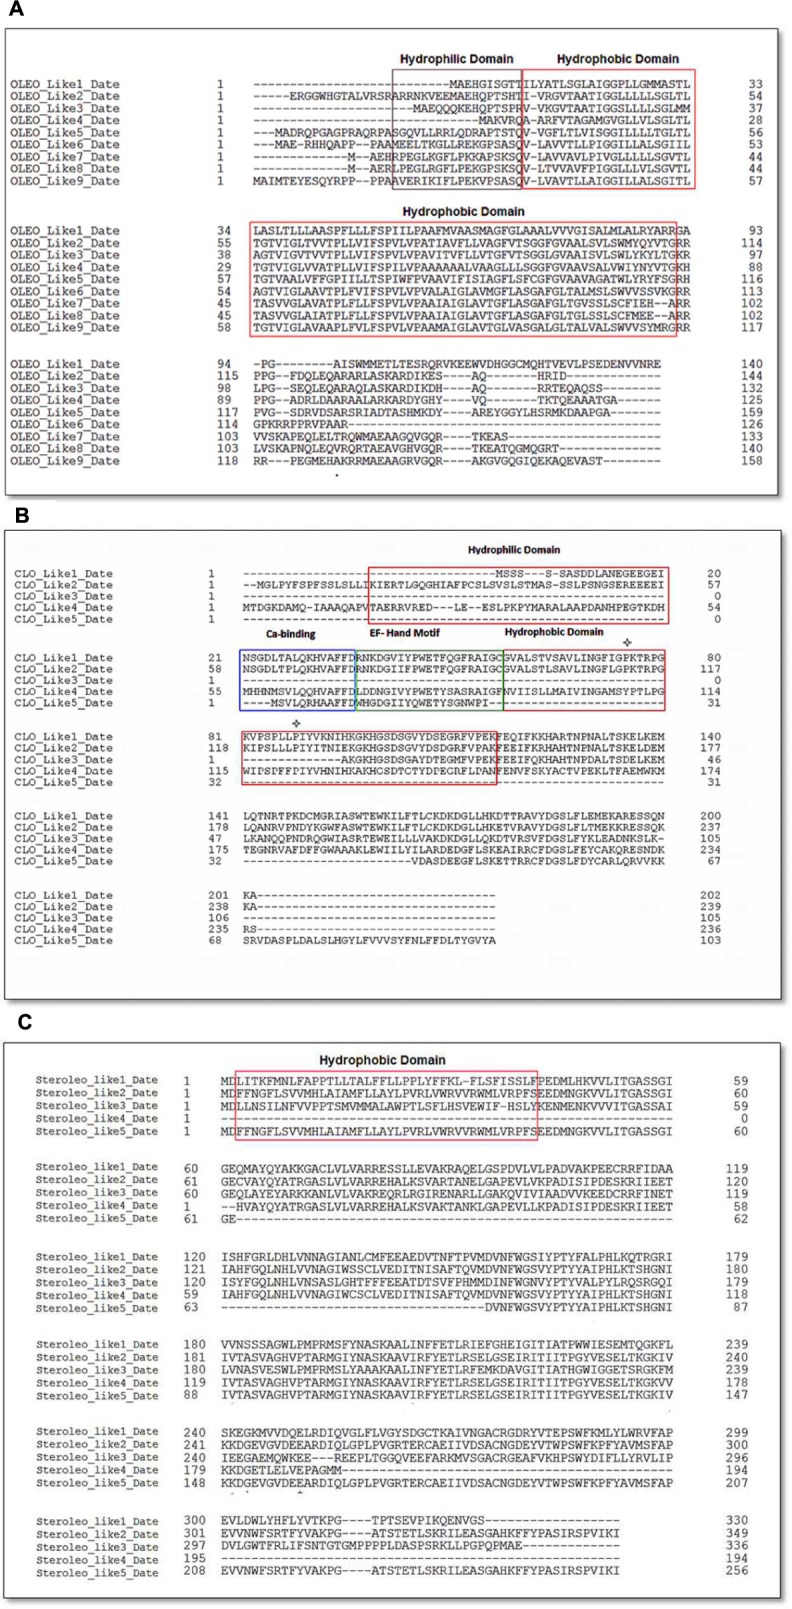
Amino acid sequence alignments of date palm oleosins (A), caleosins (B), and (C) steroleosins. Multiple sequence alignments were performed using Clustal omega. Protein domains properties were analyzed using Uniprot platform (http://www.uniprot.org). (A) Amino acid sequence alignment of date palm for oleosins. Domain colors are red for hydrophobic and brown for hydrophilic domains. (B) Amino acid sequence alignment for caleosins. Domain colors are red for hydrophobic, brown for hydrophilic domains, green for EF hand motifs and blue for Ca2+ binding domains. The ∗ notation shows the proline knot motif that starts from PK and ends at LLP. (C) Amino acid sequences alignment for steroleosins. Domain colors are red for hydrophobic and brown for hydrophilic domains.